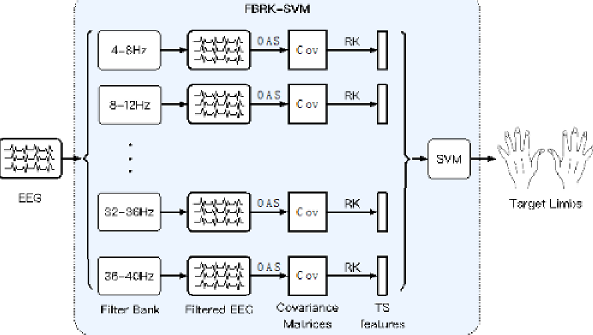
Fig. 1. The structure of FBRK-SVM